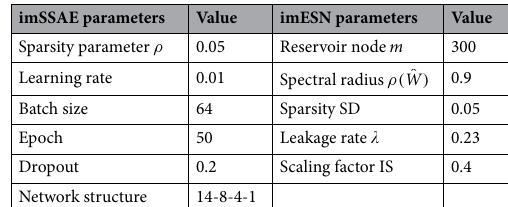
Table 3. Model optimal parameter settings.